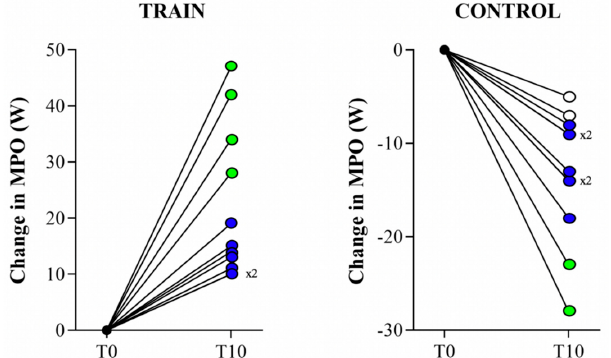
Figure 4. Power changes (W) in the standard 30 s WAnT performed before (T0) and after (T10) the 10-week velocity-based resistance training program (TRAIN) or a detraining period (CONTROL). Based on the SDC obtained in the cross-validation analysis (WAnT 15 = 22.2 W; WAnT 20 = 9.3 W), color at T10 indicates change detected by both the WAnT 15 and WAnT 20 (green circles), change detected only by the WAnT 20 (blue circles), and changes not detected by either WAnT 15 or WAnT 20 (white circles). ×2: two individuals with the same change.